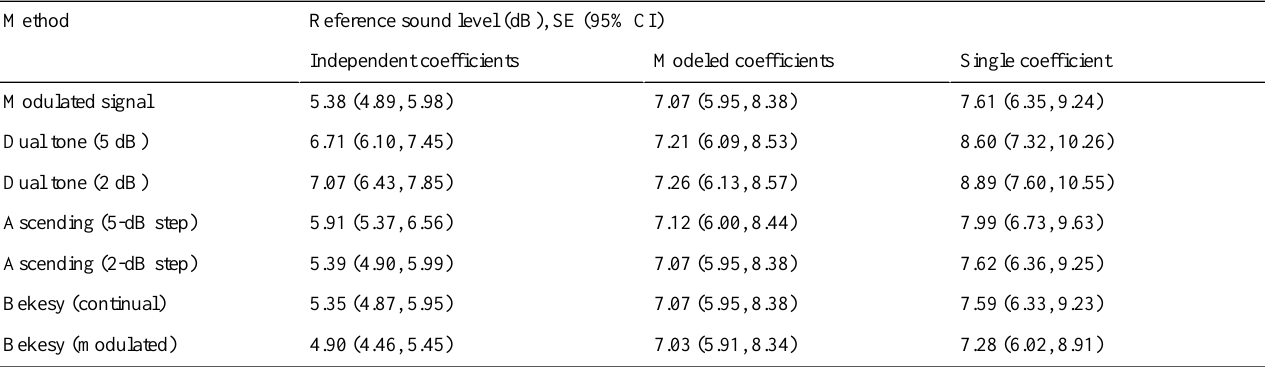
Table 4. The standard error of biological calibration with corresponding confidence intervals at P =.05 estimated on the basis of measurements carried out by 25 participants.